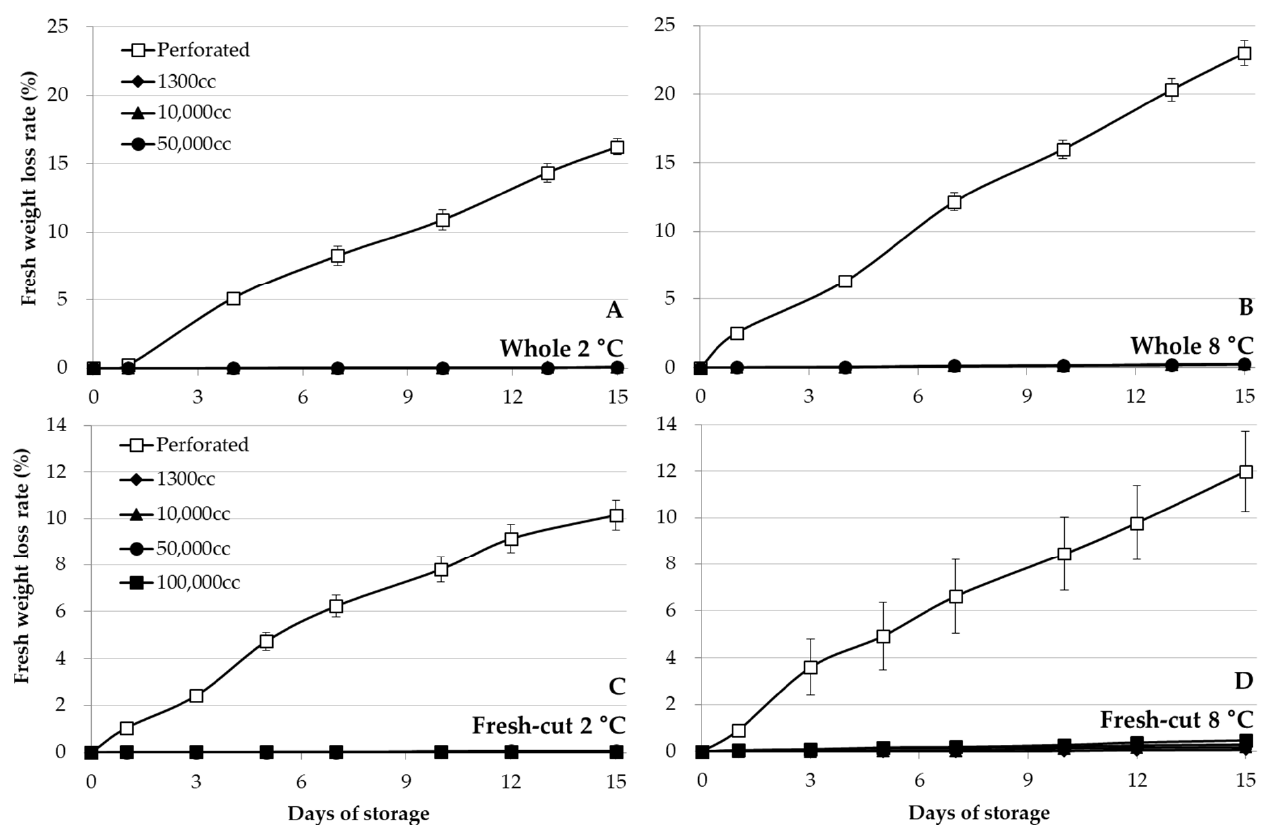
Figure 4. Change in the fresh weight loss rate of whole ( A : 2°C and B : 8°C) and fresh-cut ( C : 2°C and D : 8°C) romaine lettuce in OTR film (1300 cc; 10,000 cc; 50,000 cc; 100,000 cc·m − 2 ·day − 1 ·atm − 1 ) in MA storage at 2 and 8 °C for 15 days. Vertical bars represent ±SD of the means ( n = 5). Table 2. The overall quality, off-odor, and chlorophyll content of whole romaine lettuce in OTR film in MA storage at 2 and 8 ◦ C for 15